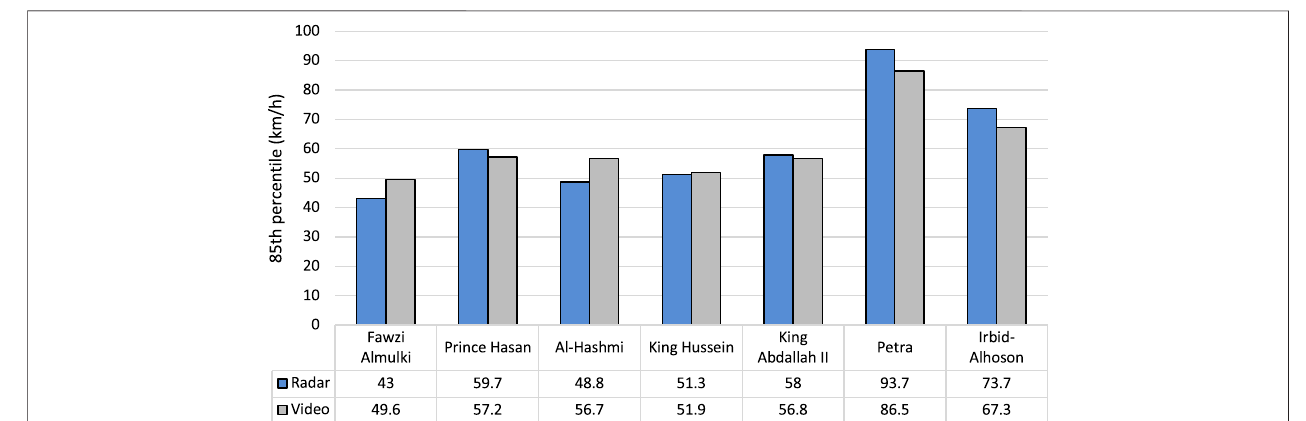
FIGURE 3 | 85th percentile speeds